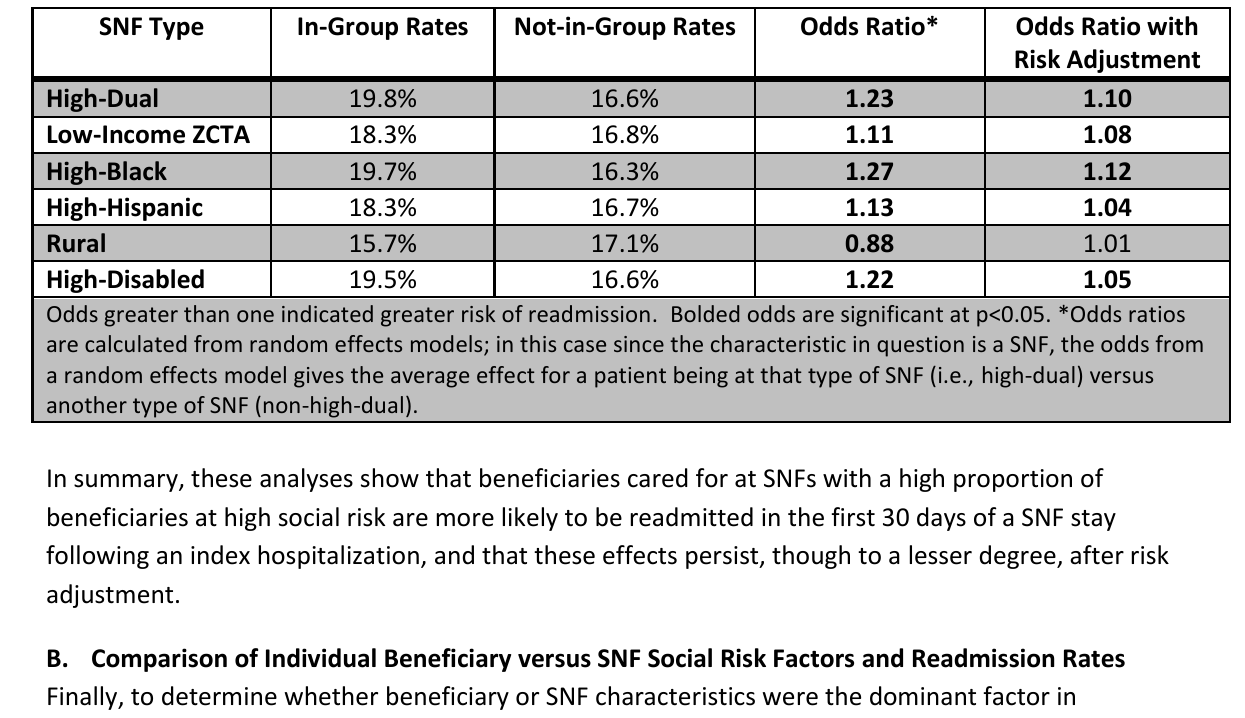
Table 12.5: SNFs Serving a High Proportion of High Social Risk Beneficiaries, Fiscal Year